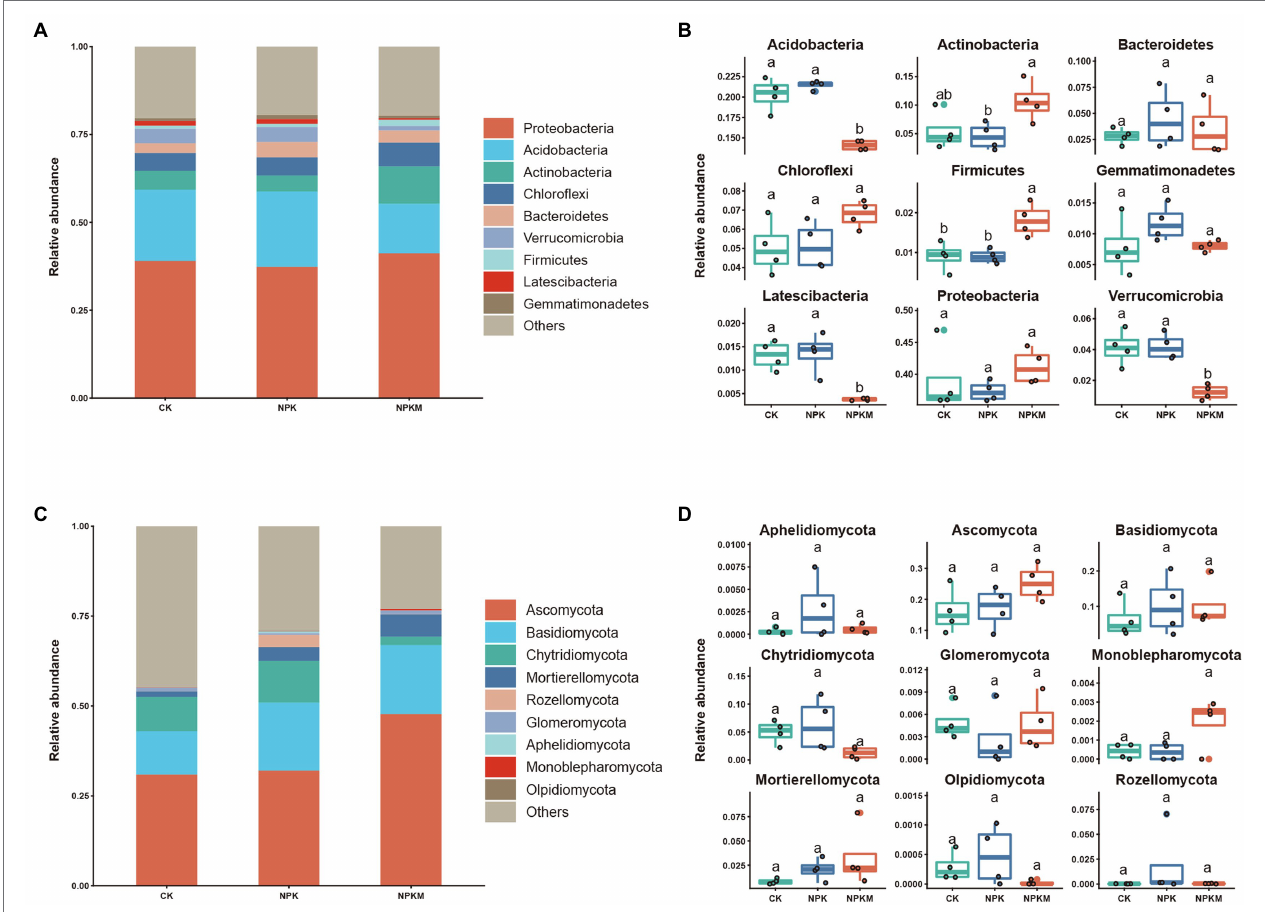
FIGURE 4 | Effects of long-term fertilization treatments on composition of bacterial and fungal communities. Phylum-level composition of (A) bacterial and (C) fungal communities. Analysis of differences in relative abundances of (B) bacterial phyla in A and (D) fungal phyla in C . Names of the nine most abundant phyla are shown, and other phyla were grouped as “Others.” Different letters indicate significant differences (Tukey’s post hoc test, p <